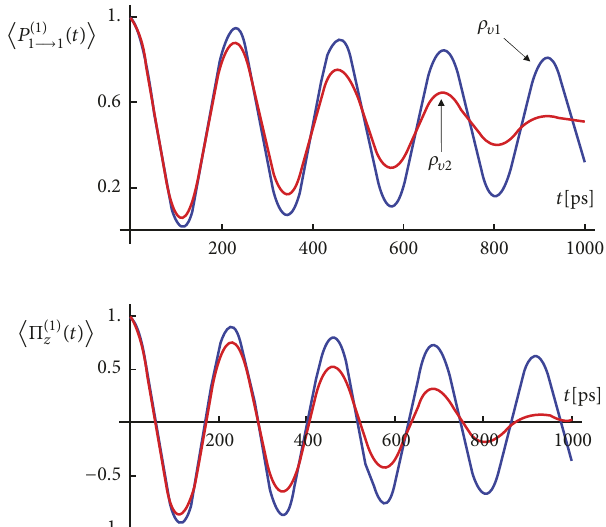
Figure 3: The survival probability (upper panel) and the spin polarization (lower panel) for two values of 𝜌 𝜐 (𝜀) , in arbitrary units. The blue curve corresponds to 𝜌 𝜐1 (𝜀) = 2 × 10 8 s −1 and the red curve to 𝜌 𝜐2 (𝜀) = 5 × 10 8 s −1 . The frequency in both cases is 𝜔 𝑜 = 2.73556 × 10 10 s −1 .